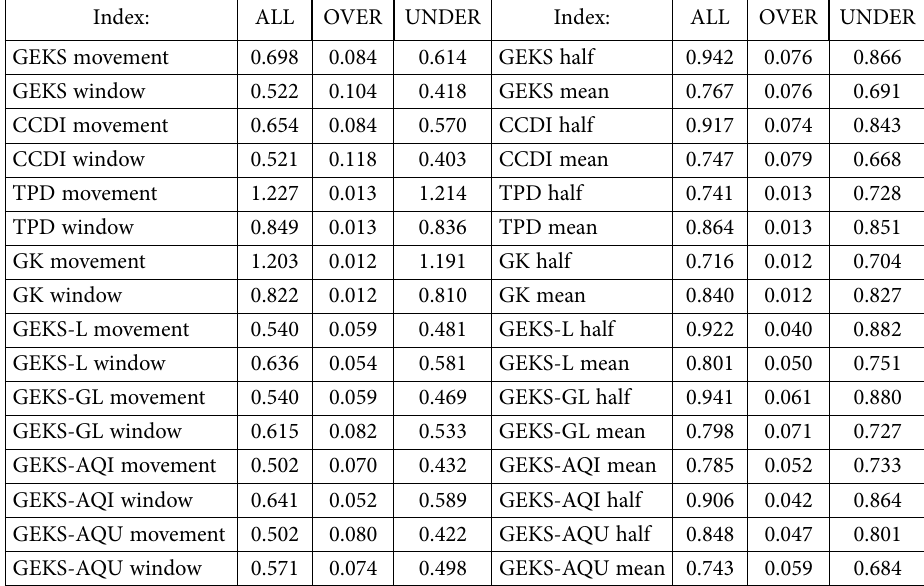
Table 6. Mean absolute distances between considered splice indices and the corresponding target full- window index for joghurt products (p.p)